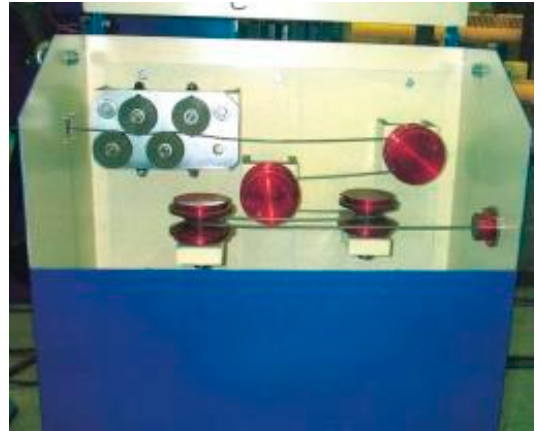
Figure 12. Eight-roller descaling machines. Table 3. Different scale removal processes of a wire rod. Reprinted with permission from ref. [21].